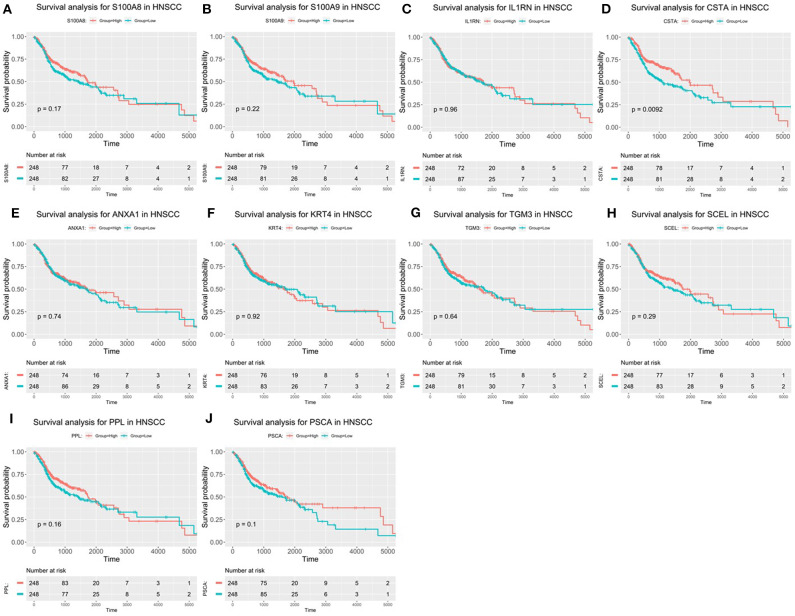
Overall survival (OS) analysis of 10 hub genes in HNSCC patients from the GEPIA2 database. (A) Survival analysis for S100A8 in HNSCC. (B) Survival analysis for S100A9 in HNSCC. (C) Survival analysis for IL1RN in HNSCC. (D) Survival analysis for CSTA in HNSCC. (E) Survival analysis for ANXA1 in HNSCC. (F) Survival analysis for KRT4 in HNSCC. (G) Survival analysis for TGM3 in HNSCC. (H) Survival analysis for SCEL in HNSCC. (I) Survival analysis for PPL in HNSCC. (J) Survival analysis for PSCA in HNSCC. The patients were stratified into high-level group (red) and low-level group (green) according to median expression of the gene. Log-rank P < 0.05 was considered to be a statistically significant difference.